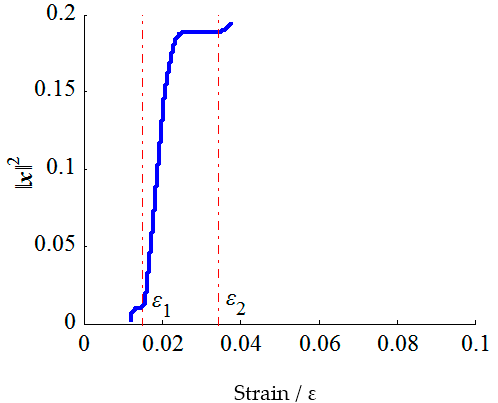
Figure 2. Least square fitting residual norm.